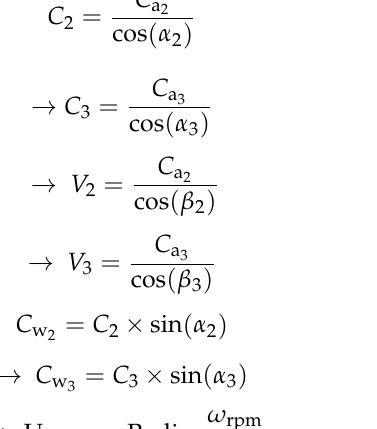
Table 7. Velocity vector data collected from preliminary design.